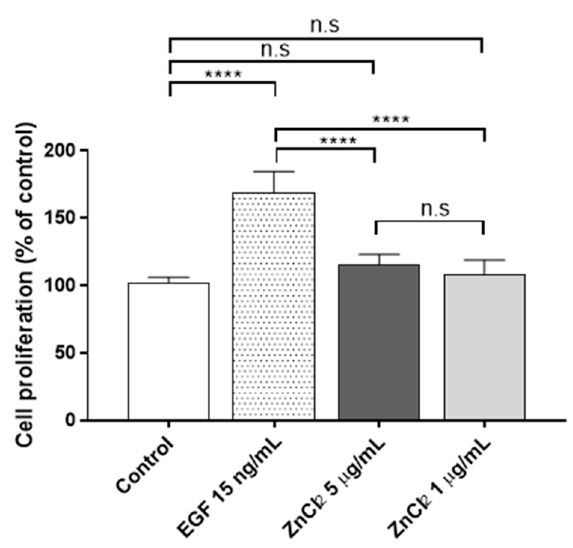
Figure 2. Proliferative activity of ZnCl 2 after 72 h of exposure in human keratinocytes. Results represented are normalized to the control group (culture media without ZnCl 2 ). Data depicted as mean ± SD of six replicates. Significant differences were determined by one-way ANOVA with Tukey’s correction for multiple comparisons: **** p > 0.0001; n.s. = not